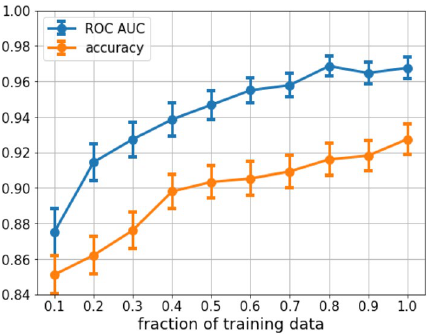
Figure 4. Training a ResNet50 model on a subsampled training dataset. The model was tested against the same 1000 test images for all the steps and statistics of the test metric was calculated with a 500 round bootstrapping. The curve proves the diversity of the Mosquito Alert dataset and also suggests that in the future when the dataset will be even larger, the classification performance will